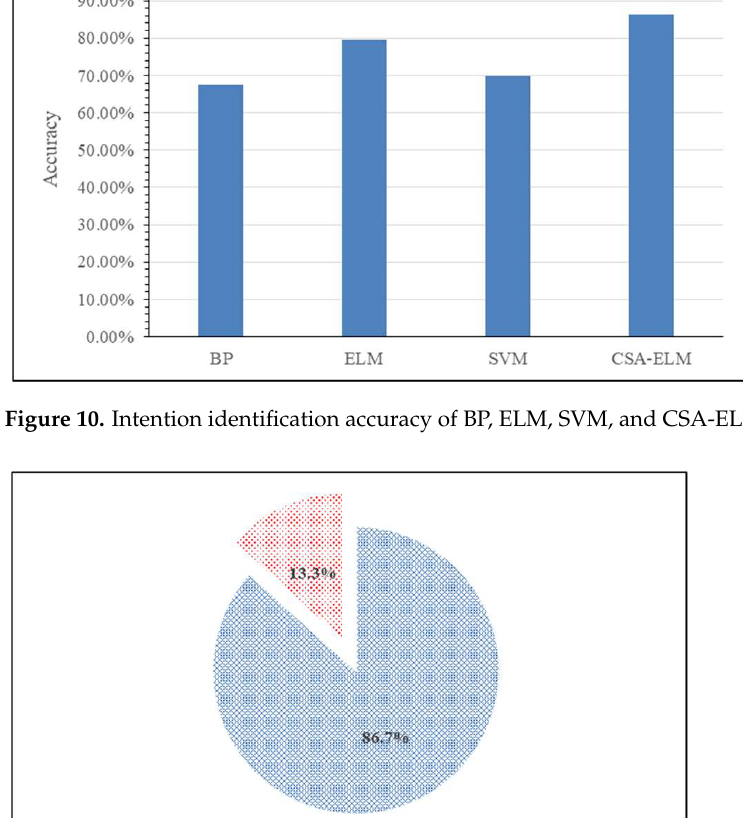
Figure 9. Comparison chart of a pilot’s intention simulation value and measured value .